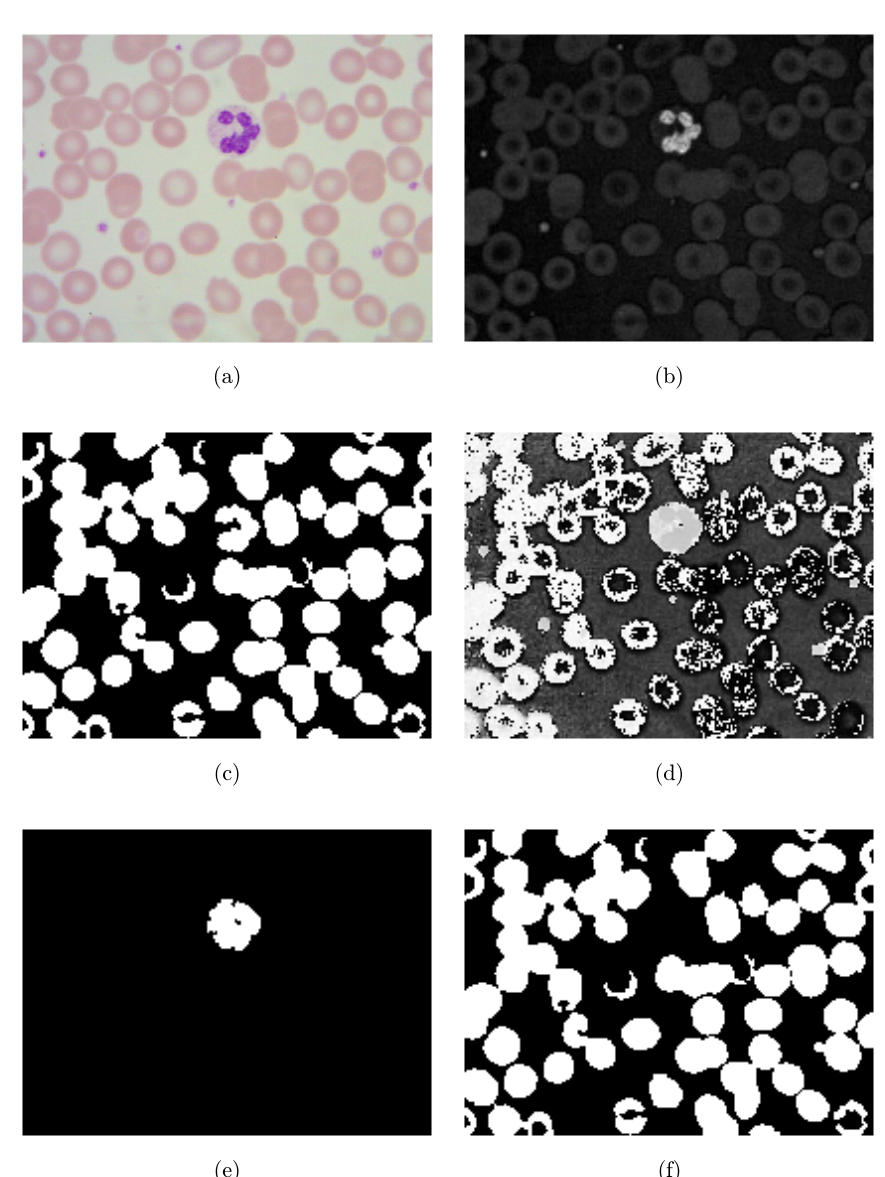
Fig. 4. Image pre-processing (a) original blood smear image, (b) S component image, (c) detection of RBCs and WBC, (d) H component image, (e) segmentation of WBC and (f) erythrocytes